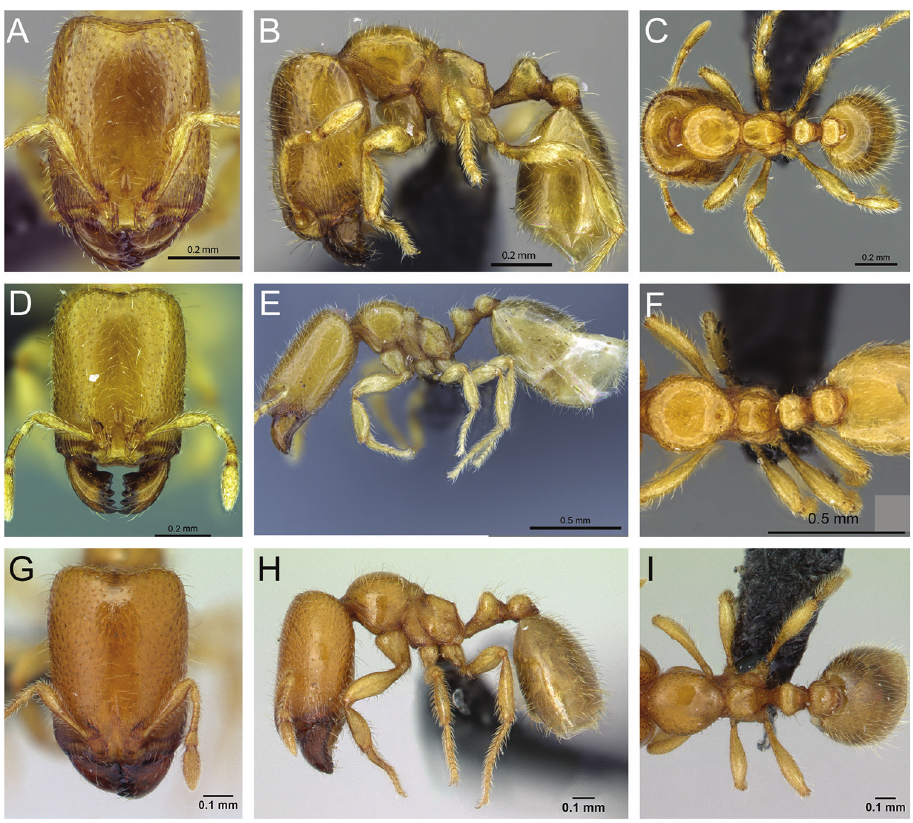
Figure 39. Intermediates of Carebara grandidieri . Major workers, CASENT0021673. A head in full-face view B body in profile view C body in dorsal view. CASENT0444643 D head in full-face view E body in profile view F body in dorsal view. CASENT0133170 G head in full-face view H body in profile view I body in dorsal